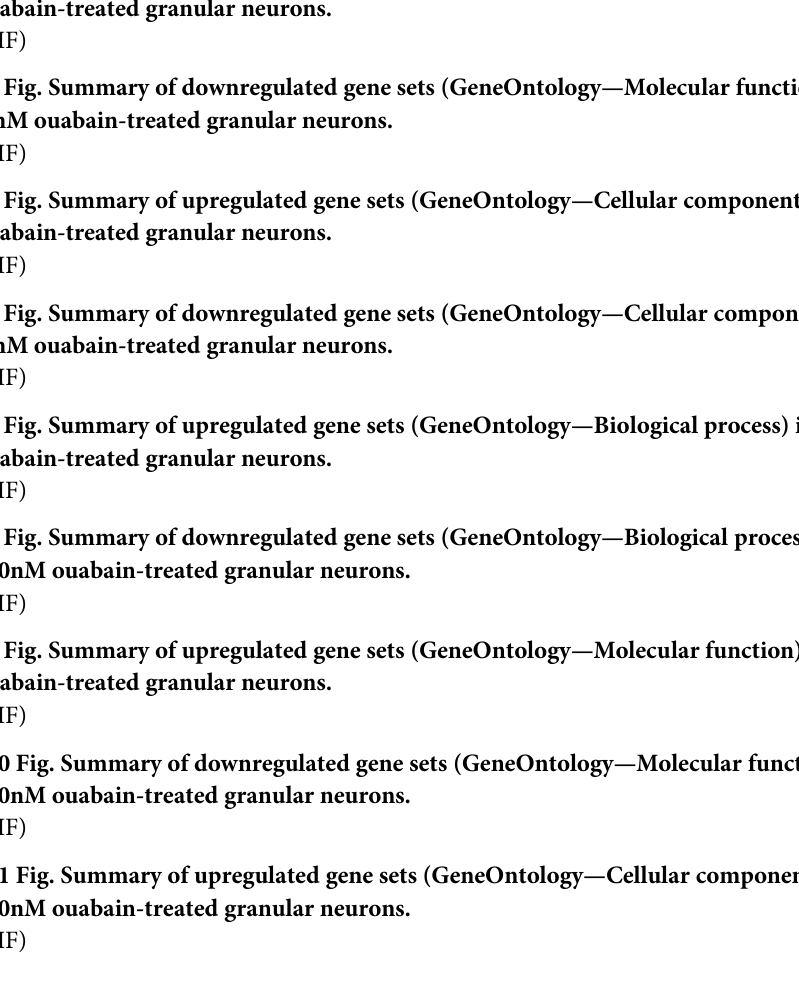
S3 Fig. Summary of upregulated gene sets (GeneOntology—Molecular function) in 1mM